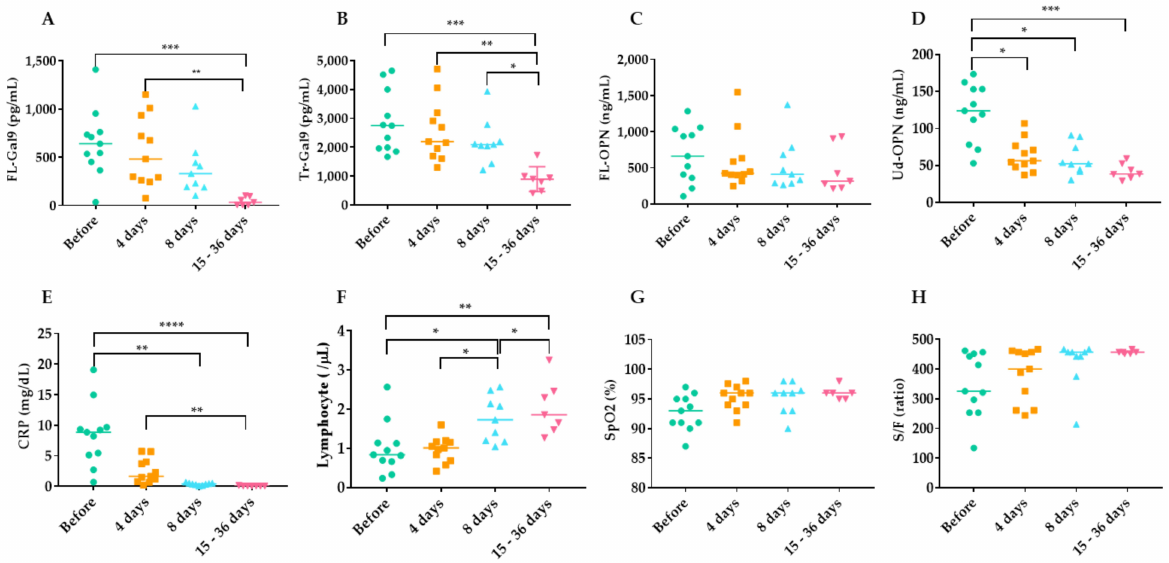
Figure 7. Effects of TCZ therapy on markers. Only those with data are shown in the figure. FL–Gal9 ( A ), Tr-Gal9 ( B ), FL-OPN ( C ), Ud-OPN ( D ), CRP ( E ), Lymphocyte ( F ), SpO2 ( G ), S/F ratio ( H ). TCZ; tocilizumab, **** p < 0.0001, *** p < 0.001, ** p < 0.01, * p <